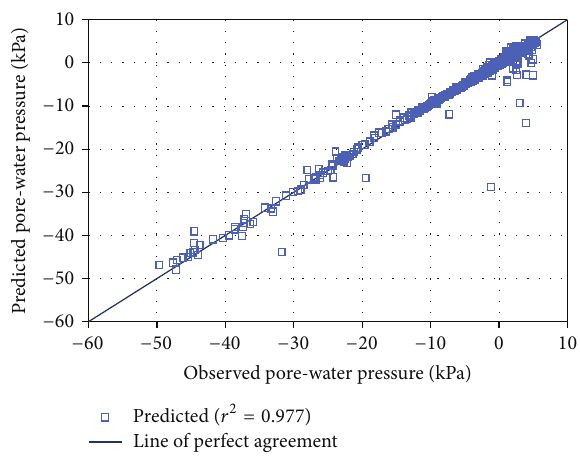
Figure 6: Comparison between observed and predicted time series of pore-water pressure obtained using the ANN model.